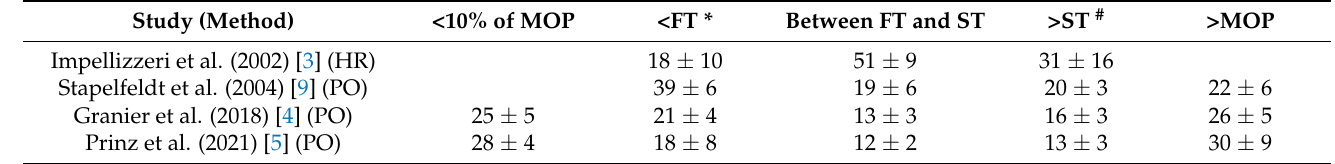
Table 3. Percentage of time spent in different intensity zones during